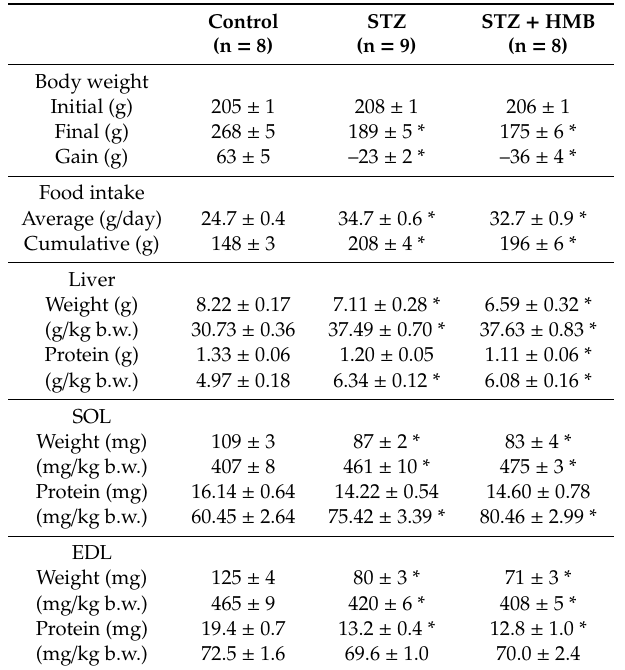
Table 2. Body weight, food intake, and weight and protein content of